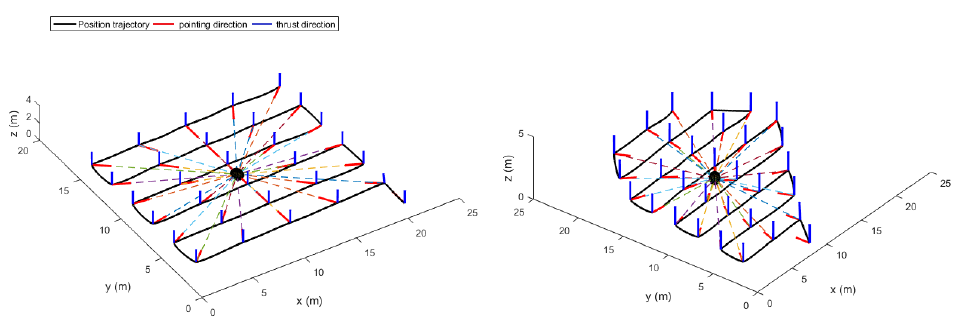
Figure 18. The pointing and the thrust direction vectors.